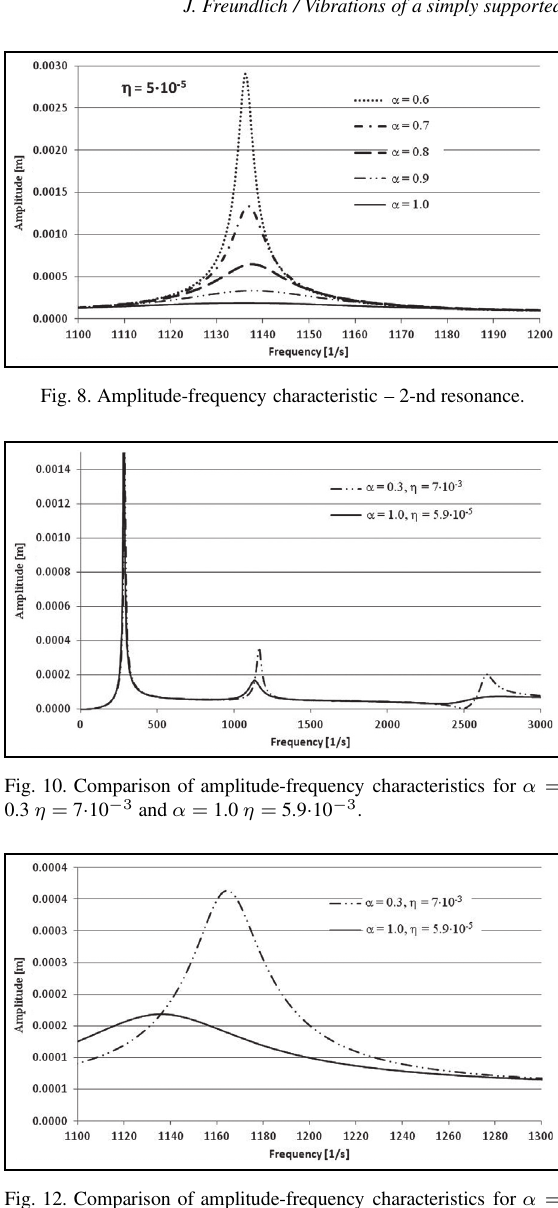
Fig. 12. Comparison of amplitude-frequency characteristics for α = 0.3 η = 7 · 10 − 3 and α = 1.0 η = 5.9 · 10 − 3 – 2-nd resonance.